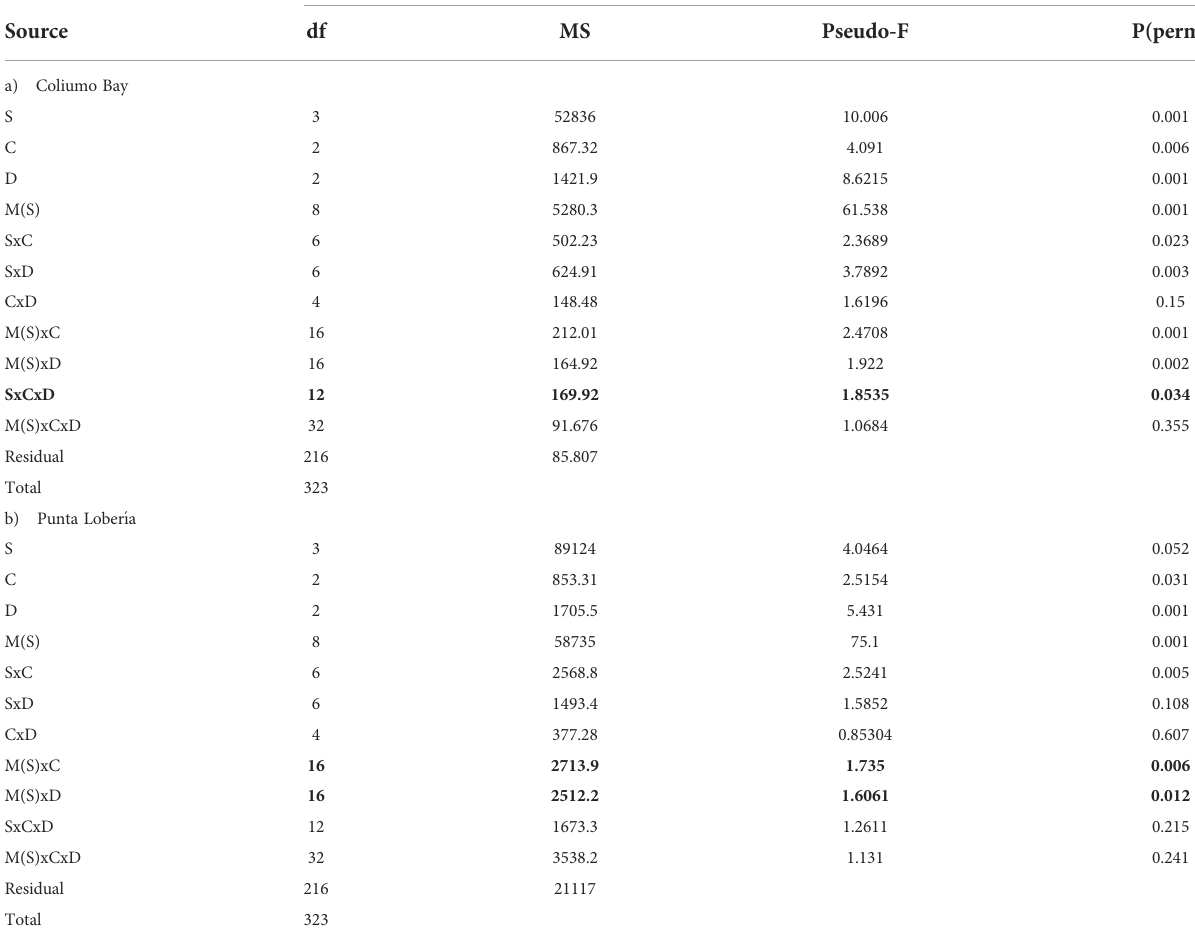
TABLE 2 PERMANOVA analyses regarding the spat density at both sites a) Coliumo Bay, b) Punta Lober ı ́